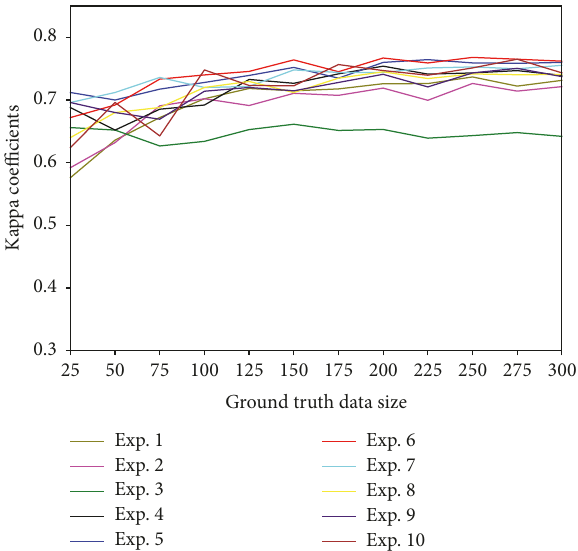
Figure3:Variationofthekappacoefficientbyincreasingtheground truth data